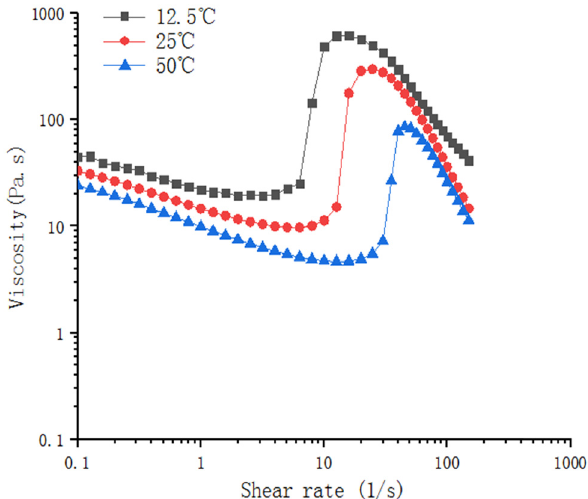
Figure 10: The steady - state viscosity - shear rate curves of the MWCNTs – PVP/SiO2 – STF system at di ff erent temperatures.